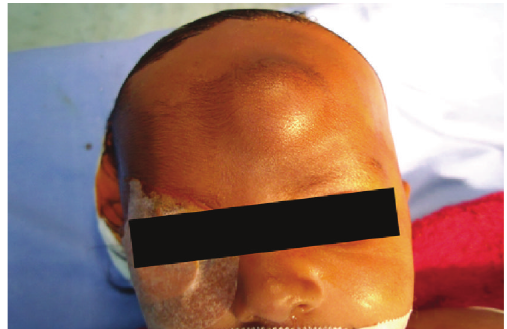
Figure 1: Swelling present on the forehead measuring 2 . 5 × 3cm in dimension.